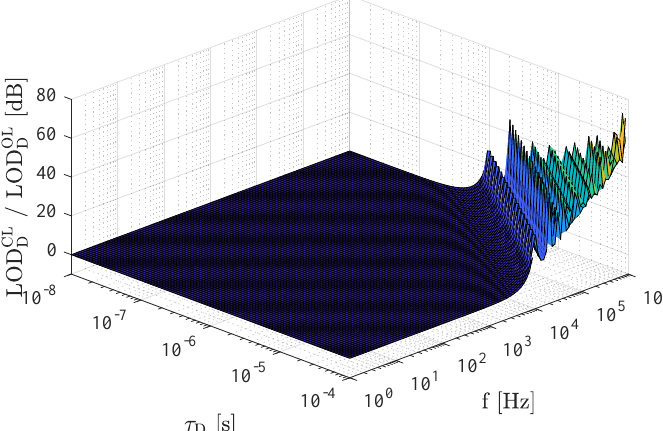
Figure 6. Ratio between the LOD in a closed-loop system (Equation (43)) and for the LOD in an open-loop system (Equation (41)) for delay line sensors. Both systems are equal for a wide range of frequencies and delay times, whereas the open-loop system is superior for sensors with large delay times and for the detection of very fast